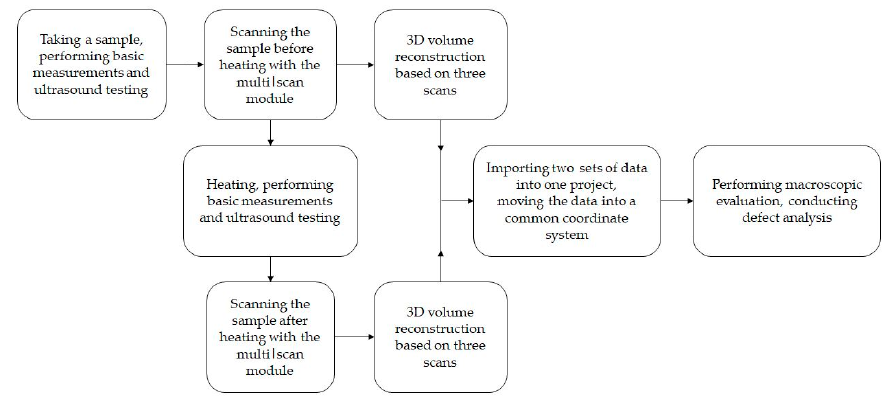
Figure 4. Data workflow.